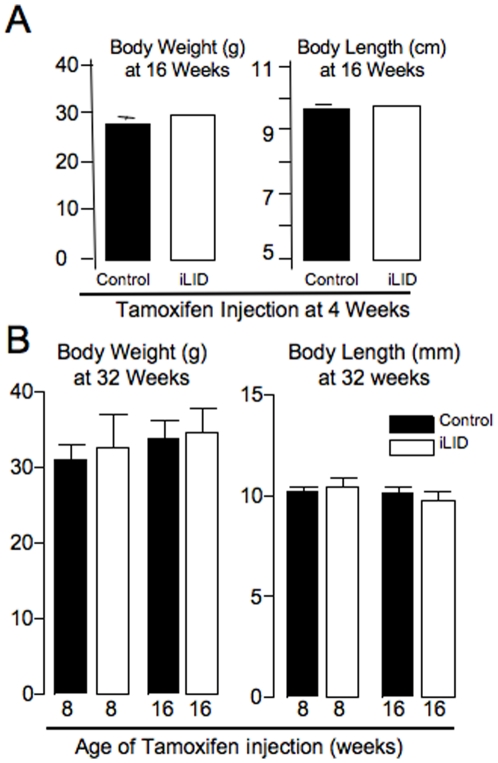
Body weight and length data for control and iLID mice.(A) Mean body weight and body length (± SE) of control (n = 6) and iLID (n = 6) mice at 16 weeks after injection of 0.3 mg of tamoxifen at 4 weeks. (B) Body weights and body lengths (± s.d) for 32 week control and iLID after injection of tamoxifen at either 8 or 16 weeks of age.